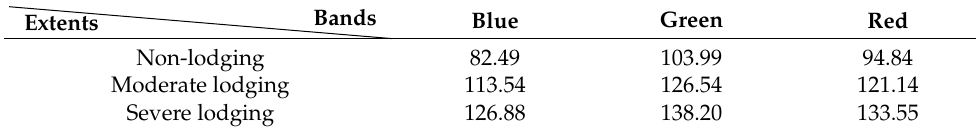
Figure 10. The intensity values variation ( left ) and the maize canopy under the UAV aerial with different lodging extents ( right ). Table 1. The average intensity values with three lodging extents in different bands.